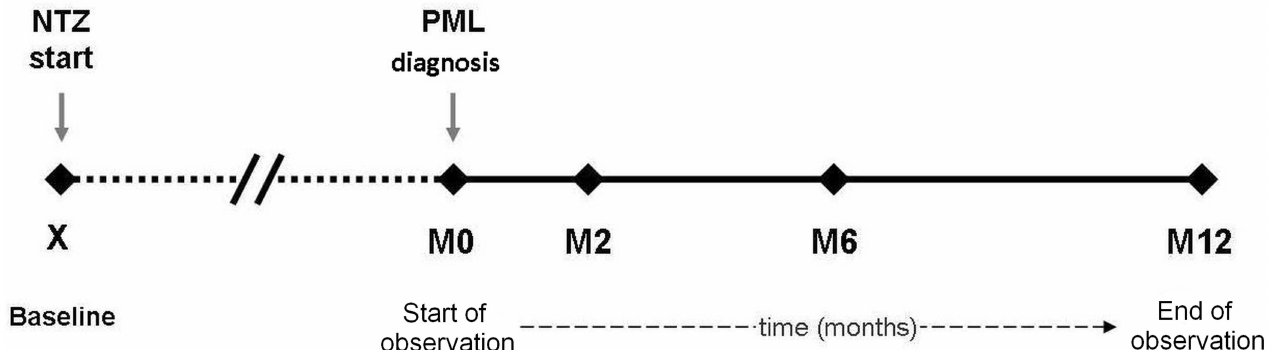
Fig 1. Assessments of patients who developed natalizumab-related progressive multifocal leukoencephalopathy.